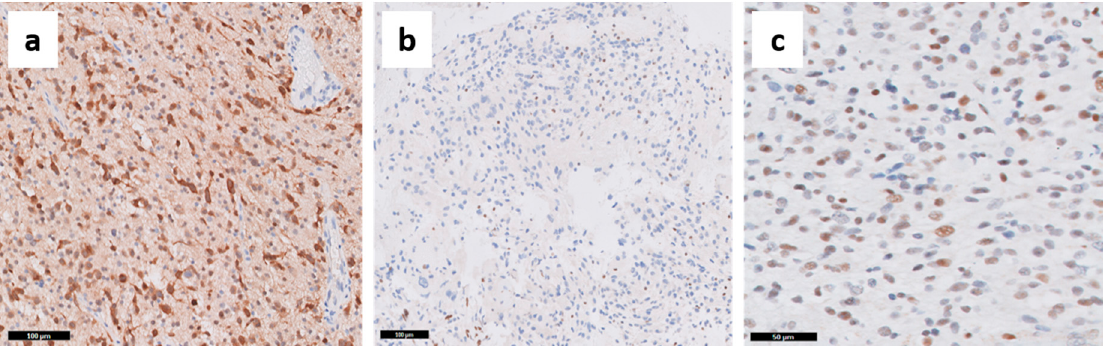
Figure 5 Figure 5. Molecular features of GBM assessed by immunohistochemistry. ( a ) IDH1 R132H, ( b ) ATRX loss (positive stain is seen in endothelial cells), and ( c ) p53 expression are diffuse in the tumor. Representative images captured from OSU Tissue